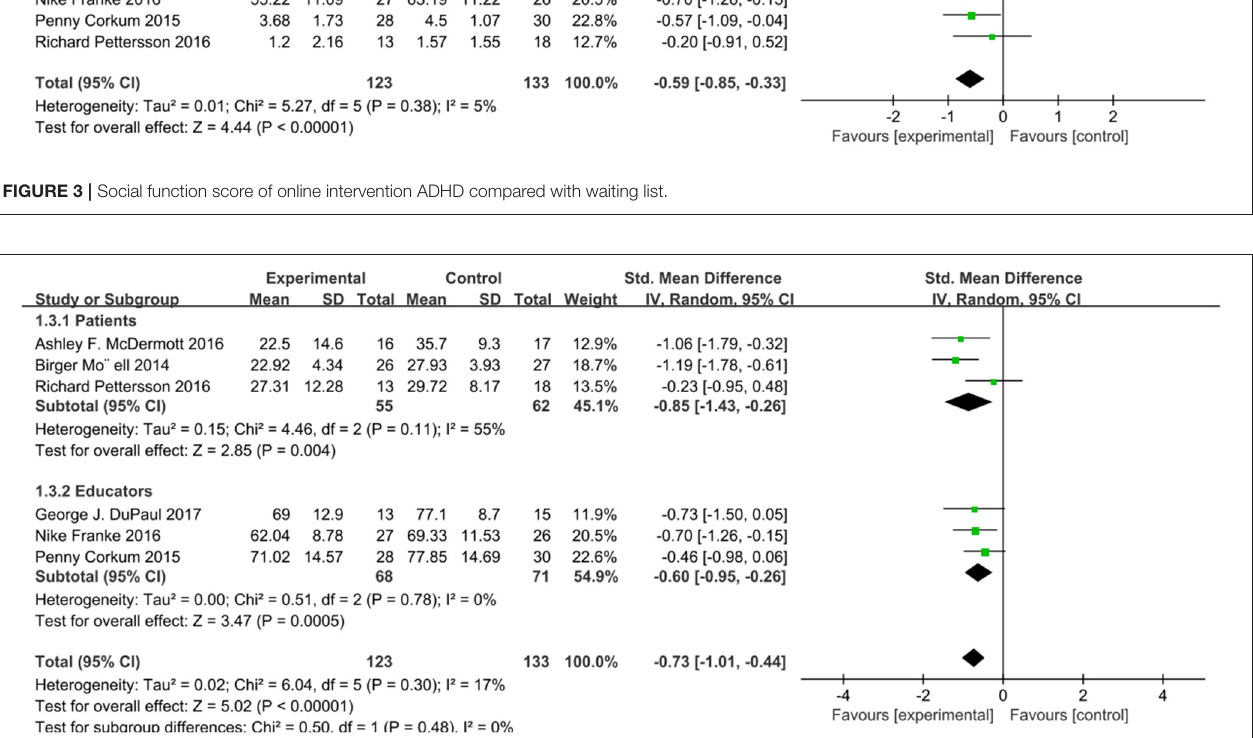
FIGURE 4 | Subgroup analysis of attention score of online intervention ADHD compared with waiting list (for patients or educators).